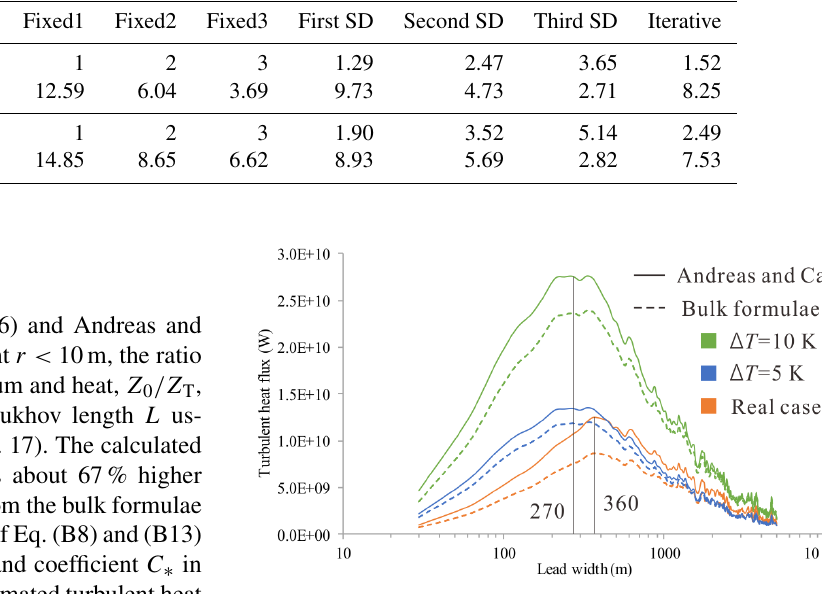
Figure 13. Contribution of heat flux from each lead width using bulk formulae and a fetch-limited model. Turbulent heat flux re- trieved using a fetch-limited model and bulk formulae are plotted using solid and dashed lines, respectively. Heat flux calculated us- ing satellite surface temperature, air temperature, and wind speed from reanalysis datasets is drawn in orange; simulated heat flux at (cid:49)T = 5 and 10K is in blue and green,